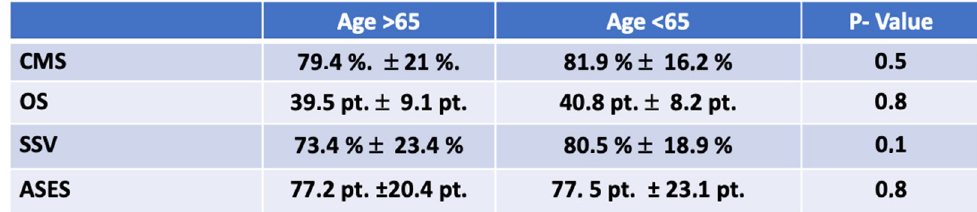
Figure 3. Clinical scores. Comparable clinical outcomes of patients over and under the age of 65 without any significant differences.